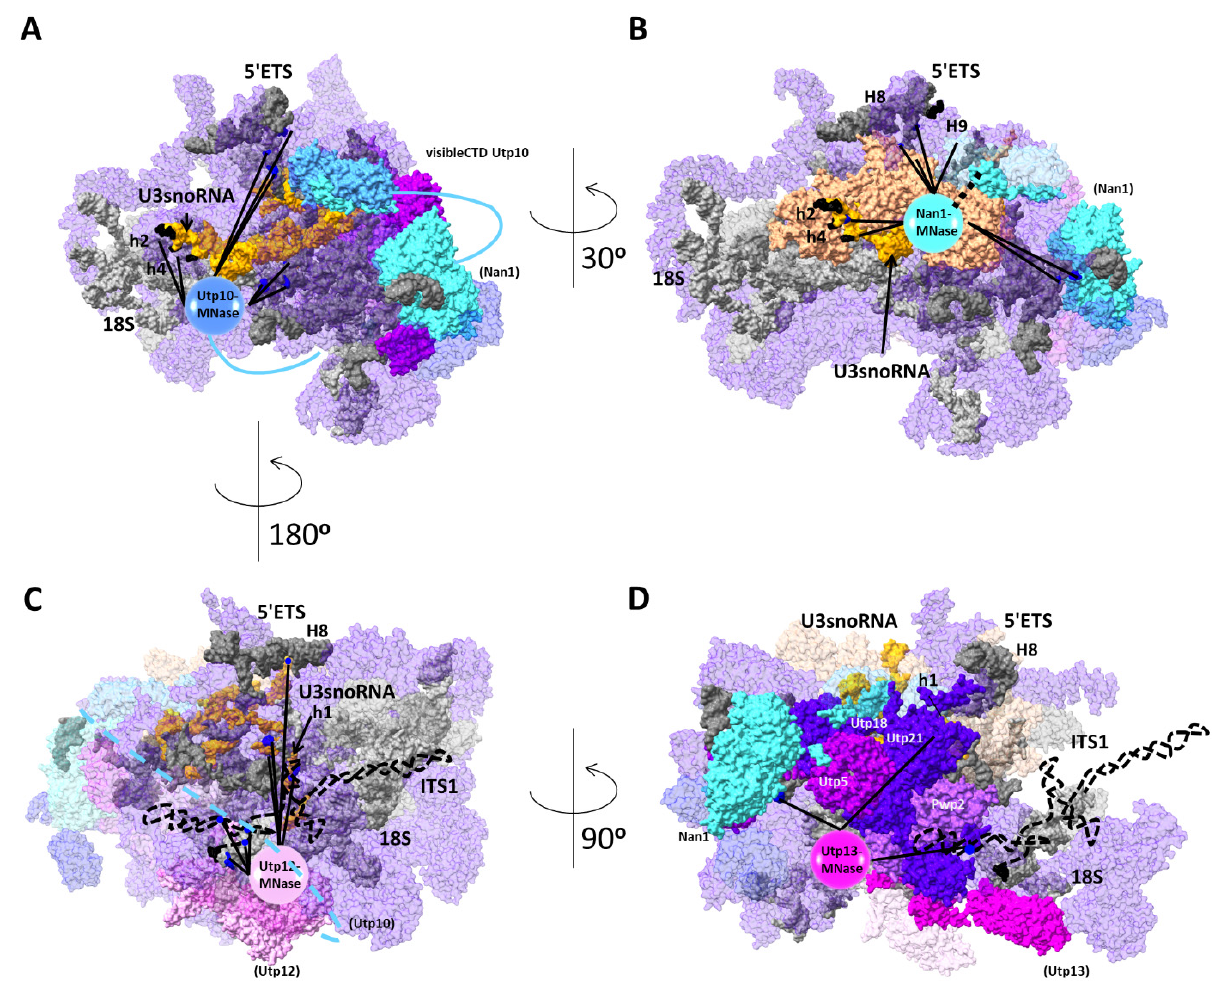
Figure 7. Prediction for localization of 5 (cid:48) ETS, ITS1, h4, and h5 of the U3snoRNA, and the CTD of proteins Nan1, Utp10, Utp12, and Utp13. Cleavages observed by tethered MNases to Utp10 ( A ), Nan1 ( B ), Utp12 ( C ), and Utp13 ( D ) are depicted. A circular form representing the MNase is placed closed to the cleavage sites observed for Utp10 or near the CTDs of Nan1, Utp12, and Utp13. Cleavage sites are indicated by lines and blue dots. The 5 (cid:48) and 3 (cid:48) end of RNA regions not visualized in cryo-EM structures are depicted in black, and not visualized regions are represented by dashed lines. Relevant elements are colorized as follows: ( A ) 5 (cid:48) ETS (light gray), 18S (dark grey), U3 snoRNA (yellow), Nan1 (cyan), Utp10 (light blue), Utp5 (violet), Pwp2 (orchid), and SSU-processome components (violet with transparency); ( B ) same as ( A ) and U3 snoRNP (wheat); ( C ) same as ( A ) and Utp12 (pale pink); and ( D ) same as ( A ) and Utp13 (fuchsia), Utp21 and Utp18 (purple). The name of relevant RNA helixes is indicated in uppercase for pre-rRNA and lowercase for the U3 snoRNA. Rotation of particles is indicated. Other proteins relevant for the interpretation are also depicted. Figures modified from pdb:5WLC, [18].